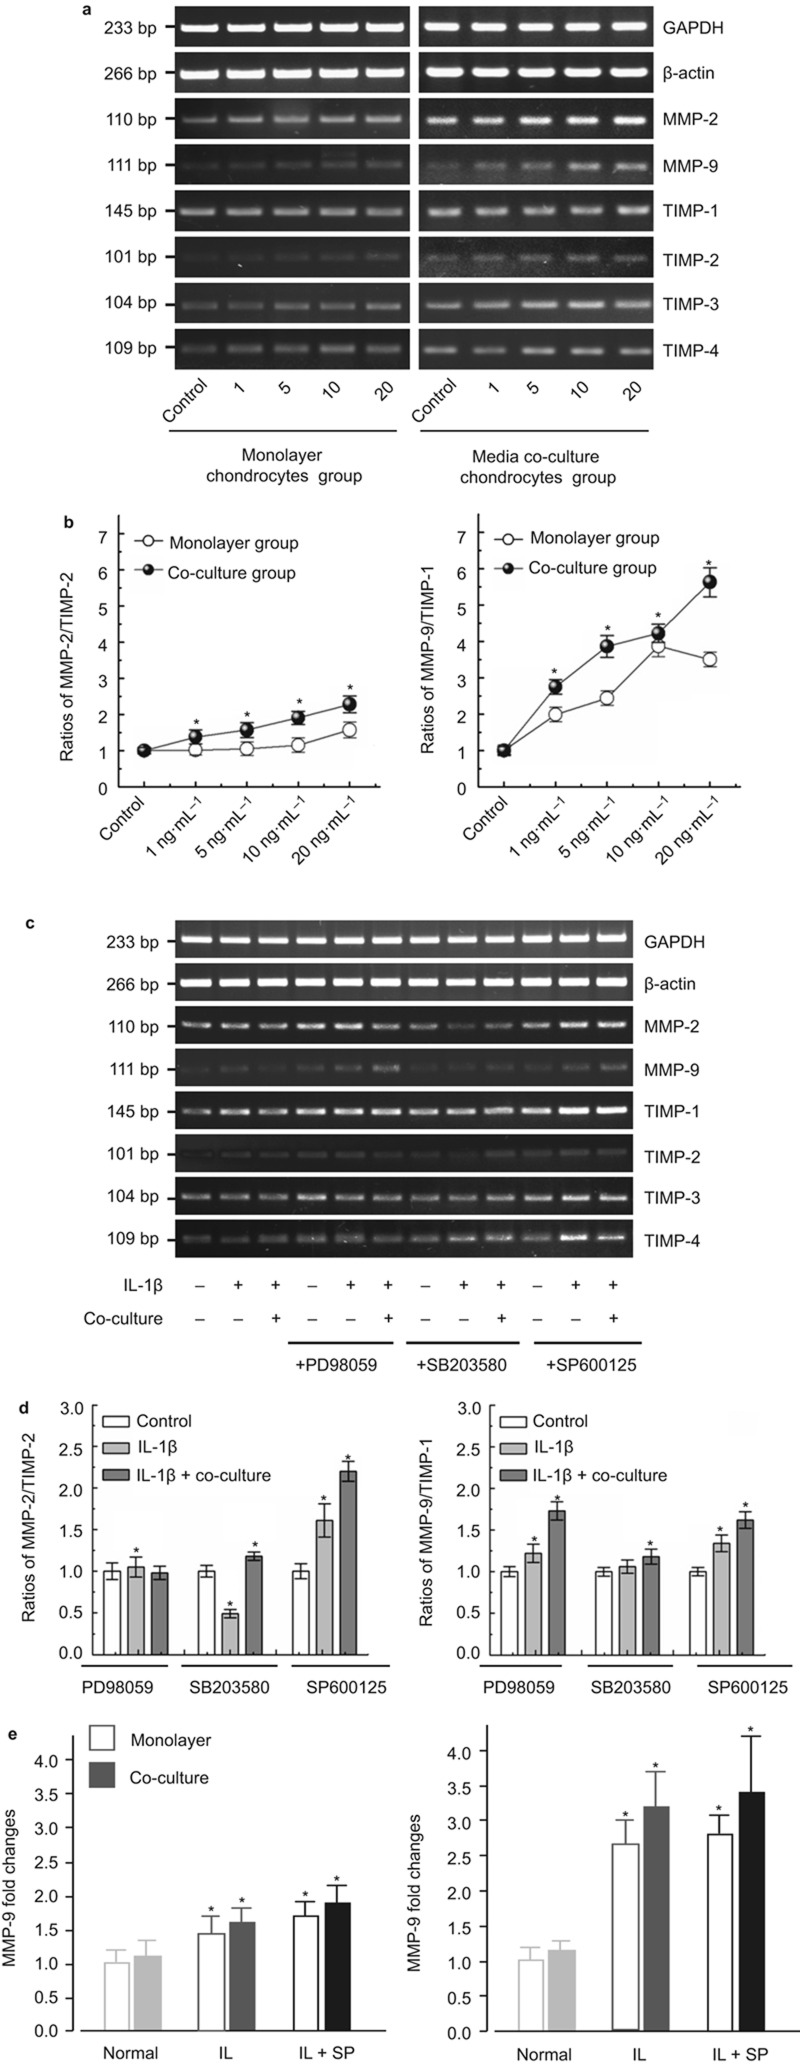
IL-1β induced gene expression of gelatinases and TIMPs in MAPK-specific inhibitor-pretreated mono-cultured and co-cultured chondrocytes. (a) IL-1β at different concentrations induces gene expression of gelatinases and TIMPs in mono-cultured and co-cultured chondrocytes.1, 5, 10 and 20 = 1, 5, 10 and 20 ng·mL−1. GAPDH and β-actin were used as the reference genes. The product sizes are indicated in the left lane. The gels shown are representative of three independent experiments (n = 3). (b) High ratios of MMP-2/TIMP-2 and MMP-9/TIMP-1 induced by different concentrations of IL-1β in inhibitor-pretreated mono-culture and co-culture chondrocytes. The data were the mean of three different experiments (n = 3). *Significant difference with respect to the normal ratios (P < 0.05). (c) The gene profiles of the gelatinases and TIMPs induced by IL-1β and/or specific inhibitors in mono-cultured and co-cultured chondrocytes. GAPDH and β-actin were used as internal controls. The product sizes are indicated in the left lane. The gels shown are representative of three independent experiments (n = 3). (d) Different ratios of MMP-2/TIMP-2 and MMP-9/TIMP-1 inhibitor-pretreated mono-cultured and media co-cultured chondrocytes. The data are the mean of three different experiments (n = 3). *Significant difference with respect to control ratios (P < 0.05). (e) qPCR was done to confirm the gene expressions of gelatinases induced by IL-1β in mono-culture and co-culture group. *Significant difference with respect to monolayer chondrocytes (P < 0.05). GAPDH, glyceraldehyde-3-phosphate dehydrogenase; IL, interleukin; MMP, metalloproteinase; TIMP, tissue inhibitors of metalloproteinase.